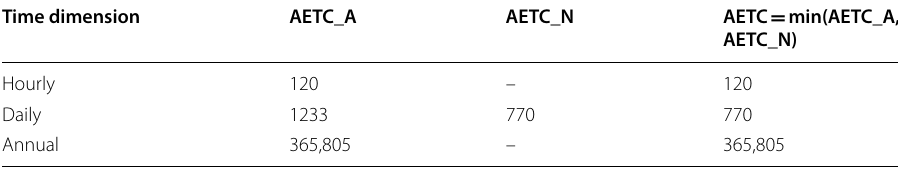
min(AETC_A, = AETC_N)